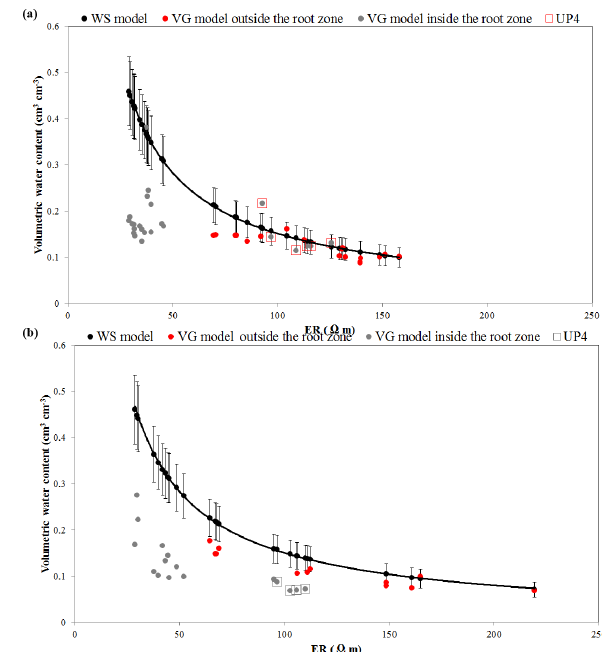
Figure 8. Relationship between VWC and ER in the topsoil for (a) the wet period (T01 to T06) and (b) the dry period (T07 to T10). Black circles with standard deviation indicate VWC from the Wax- man and Smits model. Red and gray circles indicate VWC predicted from the retention curve outside and inside the root zone, respec- tively.